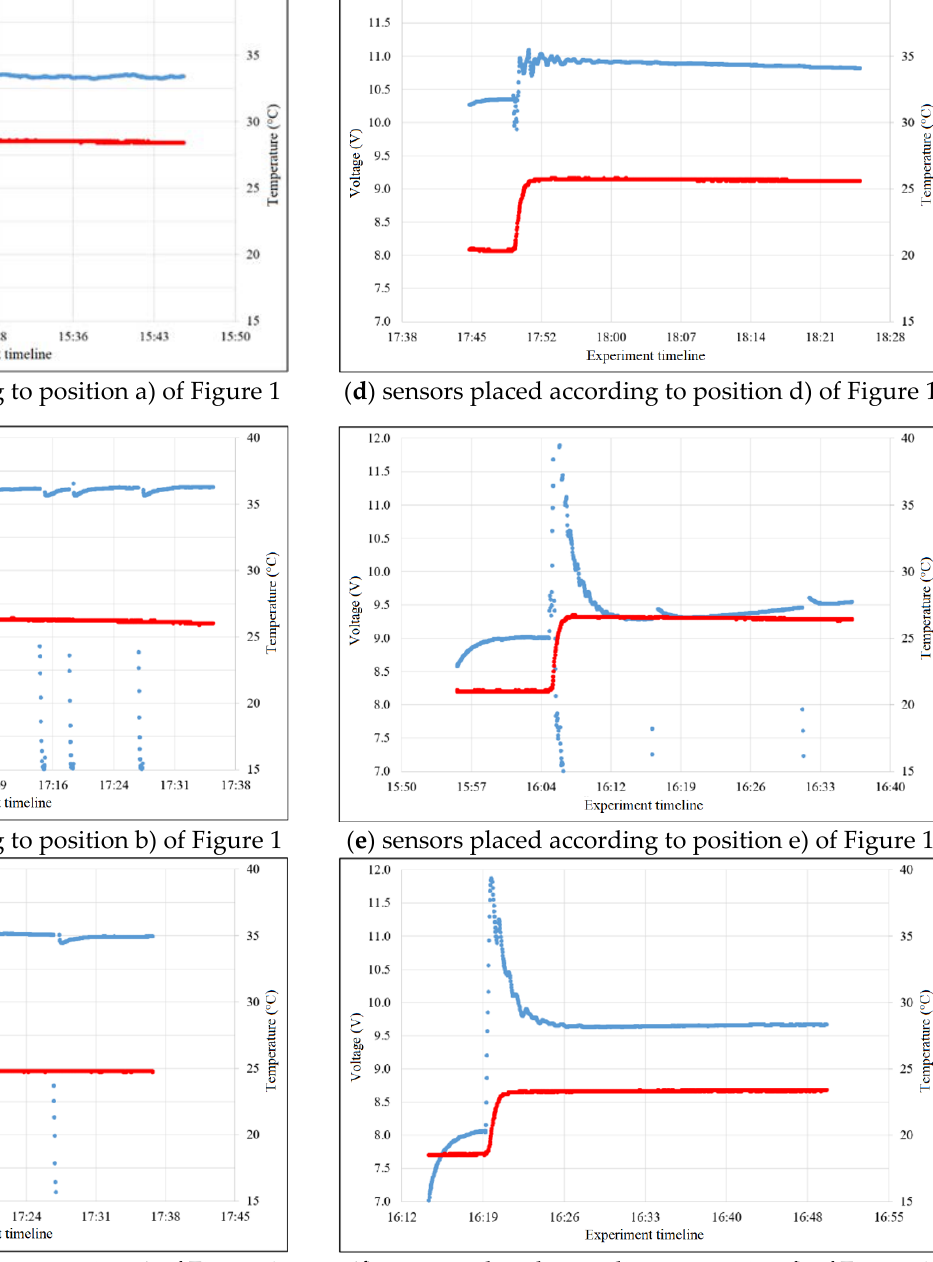
Figure 4. Thermal transfer characterization (blue curve—output signal from the TDS; red curve—water temperature) of sensor configurations shown in Figure 1.